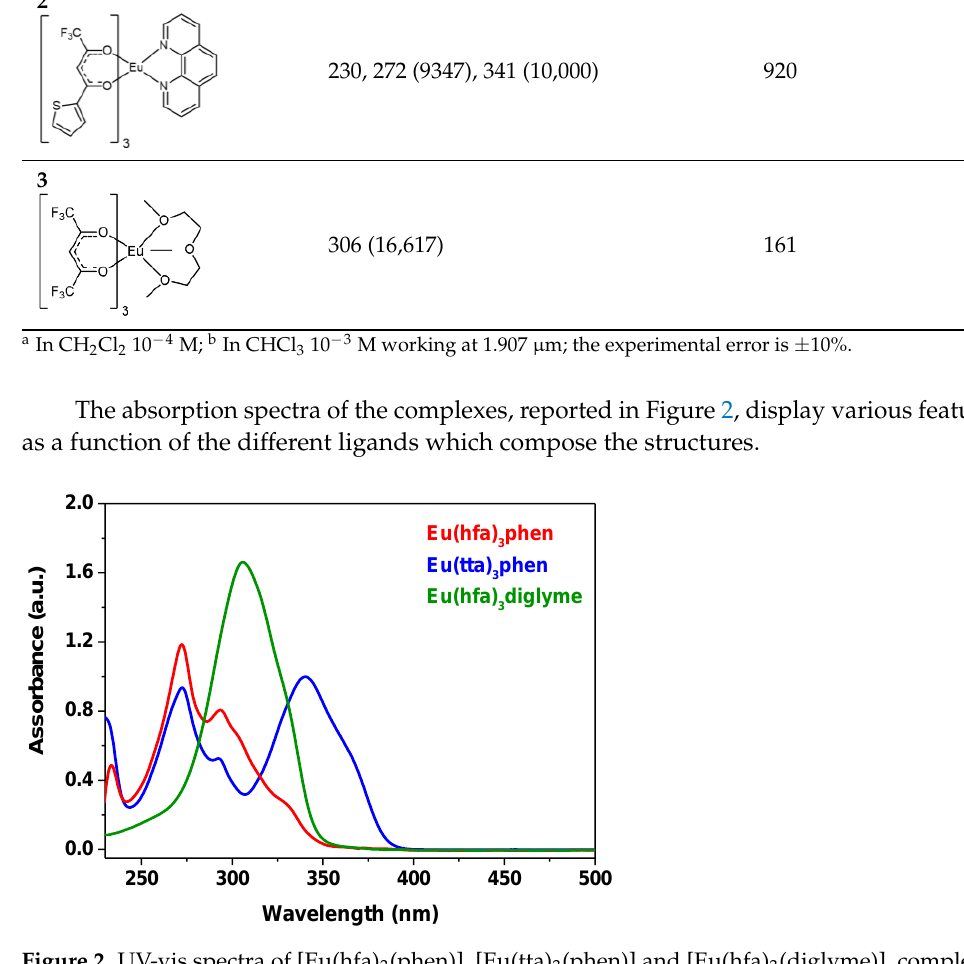
Figure 2. UV-vis spectra of [Eu(hfa) 3 (phen)], [Eu(tta) 3 (phen)] and [Eu(hfa) 3 (diglyme)], complexes from 1 × 10 − 4 M solutions in CH 2 Cl 2 .